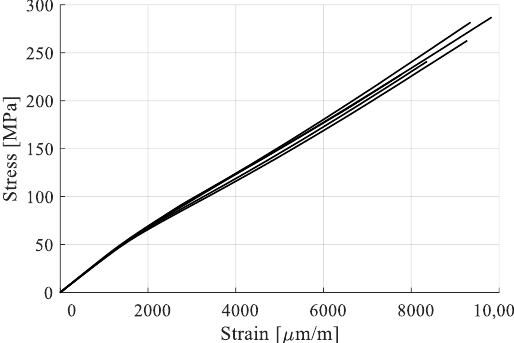
Figure 7. Stress – strain curves of flax fiber — epoxy resin composites. Figure 7. Stress–strain curves of flax fiber—epoxy resin composites.